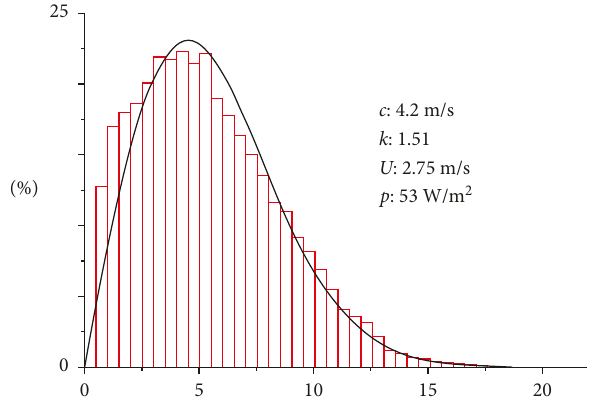
Figure 4: The Weibull distribution belonging to Arapgir Province.